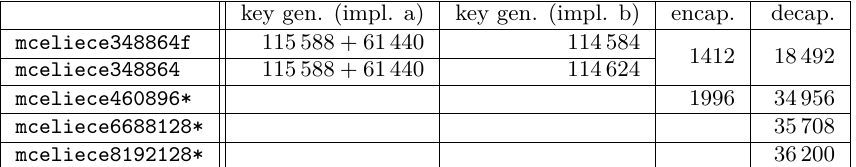
Table 11: Stack usage for the three operations. key gen. (impl. a) key gen. (impl. b)